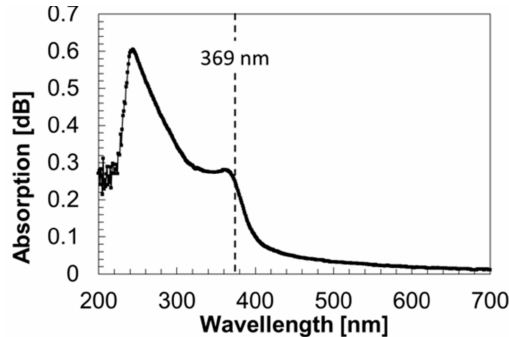
Figure 5. Absorption spectrum of the fabricated ZnO film.